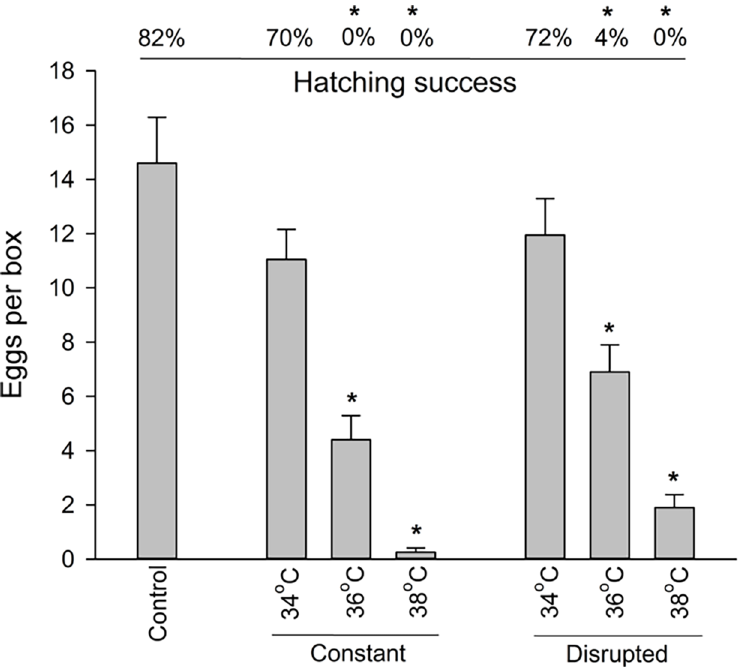
Fig 2. Egg production and hatching success of Cimex lectularius during heat stress. Egg production (mean number of eggs per box) and hatching success (nymphs/eggs in percent) in populations during the constant and disrupted heat treatments. Data from the 2 and 3 week treatments are pooled. (cid:3) denotes significant difference relative to control (Dunnett’s method, p <